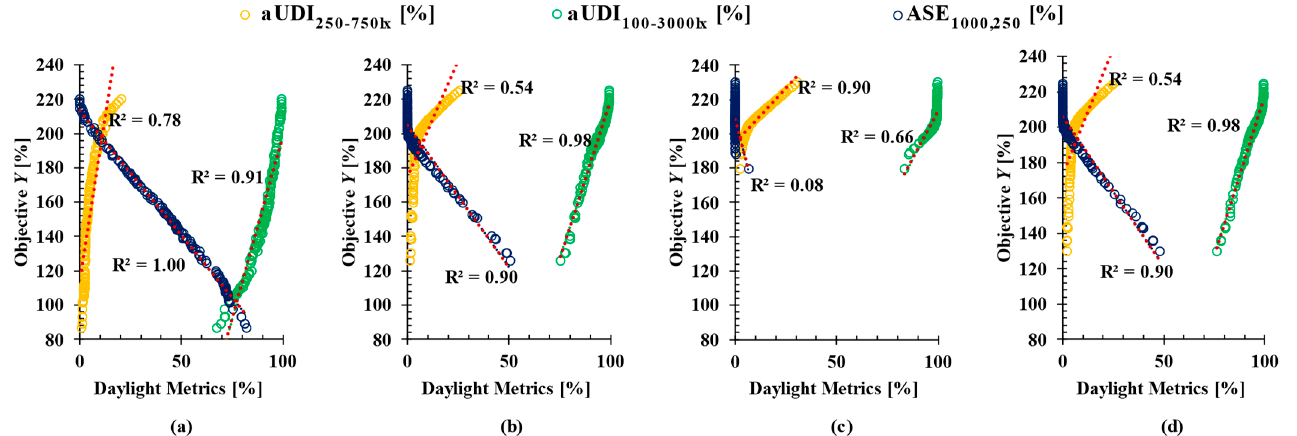
Figure 9. Relationship between each daylight metric and the objective function Y at orientation: ( a ) 0°, ( b ) 45°, ( c ) 90°, and ( d ) 135°.